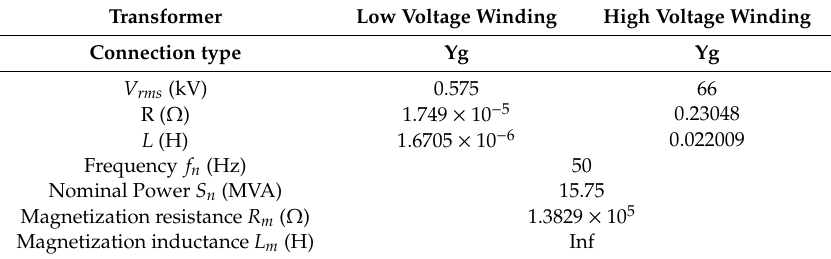
Table A1. Parameters of the three-phase 0.575 / 66 kV transformer of Wind farm A.